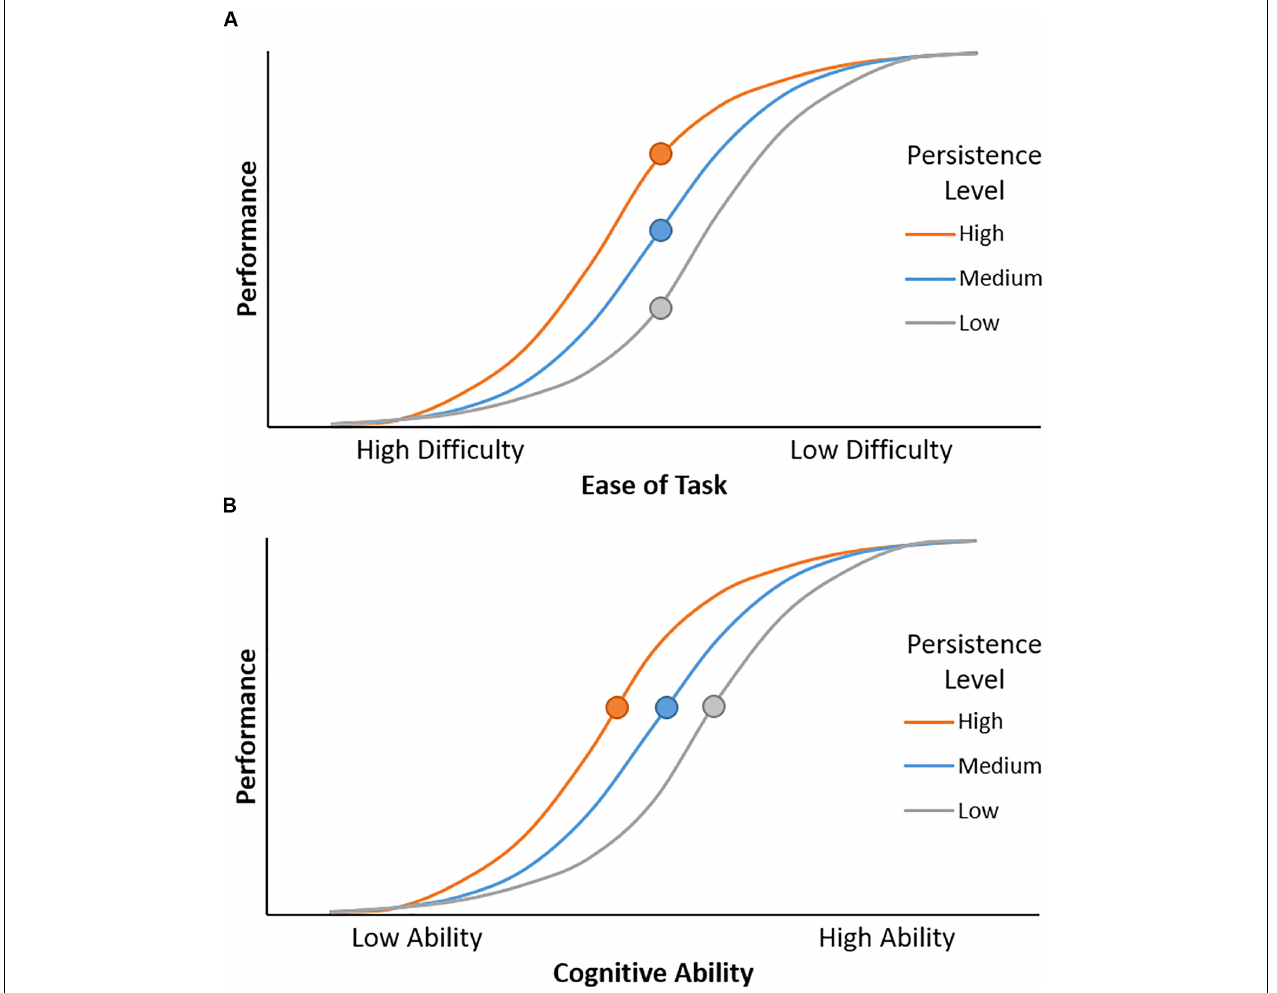
FIGURE 1 | (A) Cognitive persistence modulates the relationship between ease of task and performance. Performance increases as the task becomes easier. Given equivalent task difficulty, individuals with higher levels of persistence have better performance. This effect is maximal at intermediate levels of task difficulty (circles). (B) Cognitive persistence modulates the relationship between cognitive ability and performance. Performance increases as cognitive ability increases, but high cognitive persistence can offset low cognitive ability. Specifically, an individual with relatively low cognitive ability but high persistence (orange circle) can achieve the same level of performance as individuals with higher ability but lower persistence (blue and gray